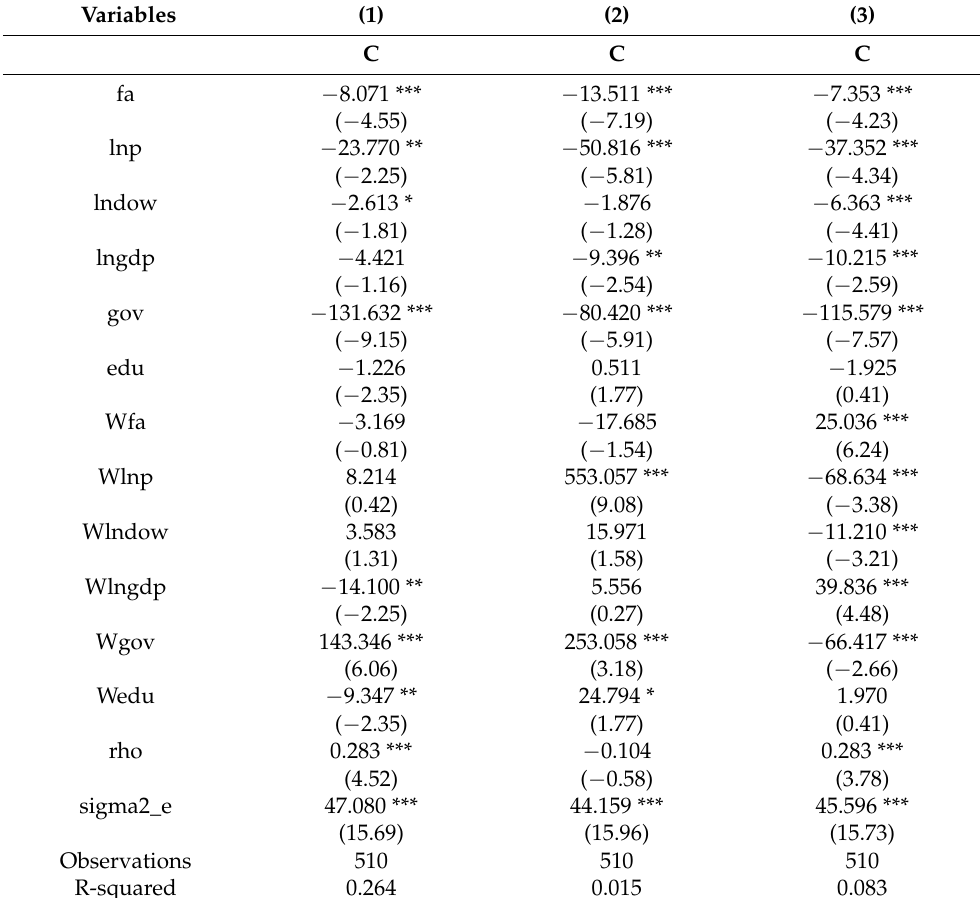
Table 9. Regression results of spatial econometric